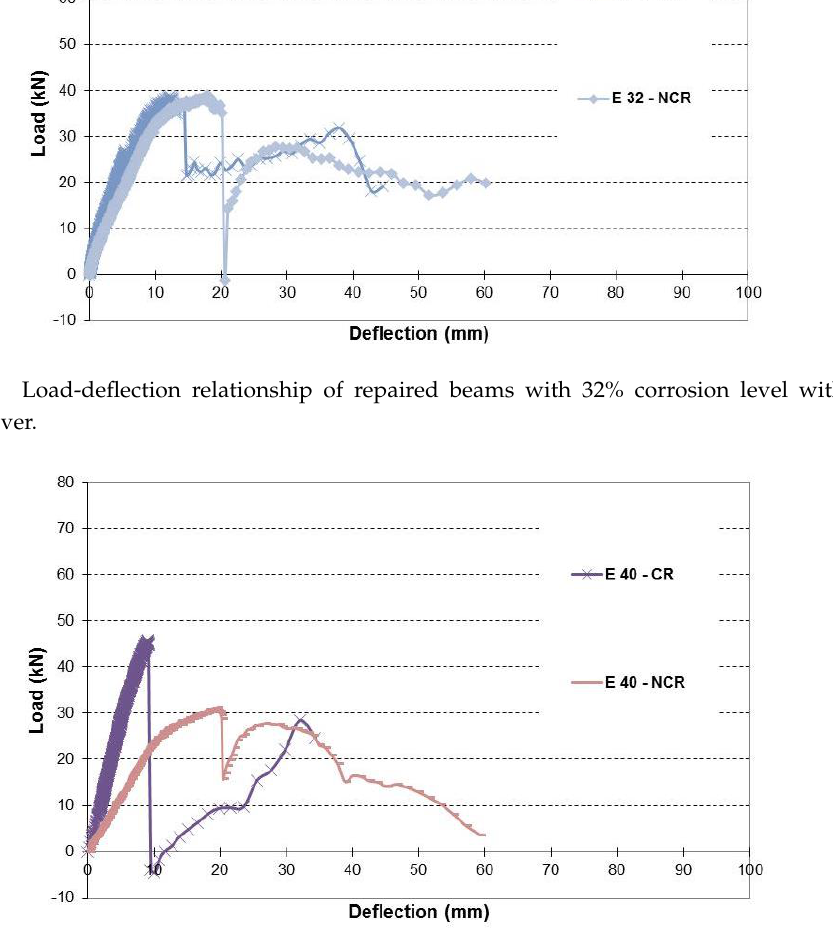
Figure 26. Load-deflection relationship of repaired beams with 40% corrosion level with and without cover.